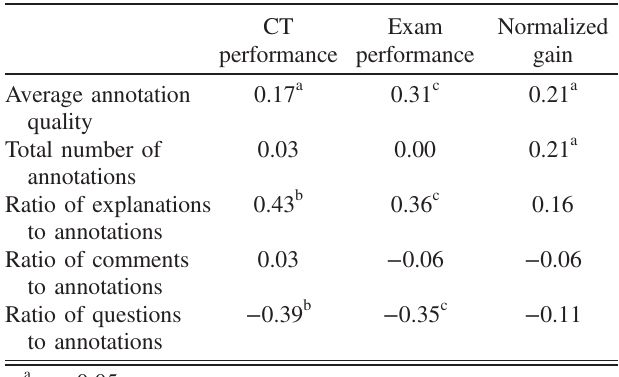
TABLE IV. Correlations between students ’ in-class learning metrics and their annotation metrics (number of students, N ¼ 161